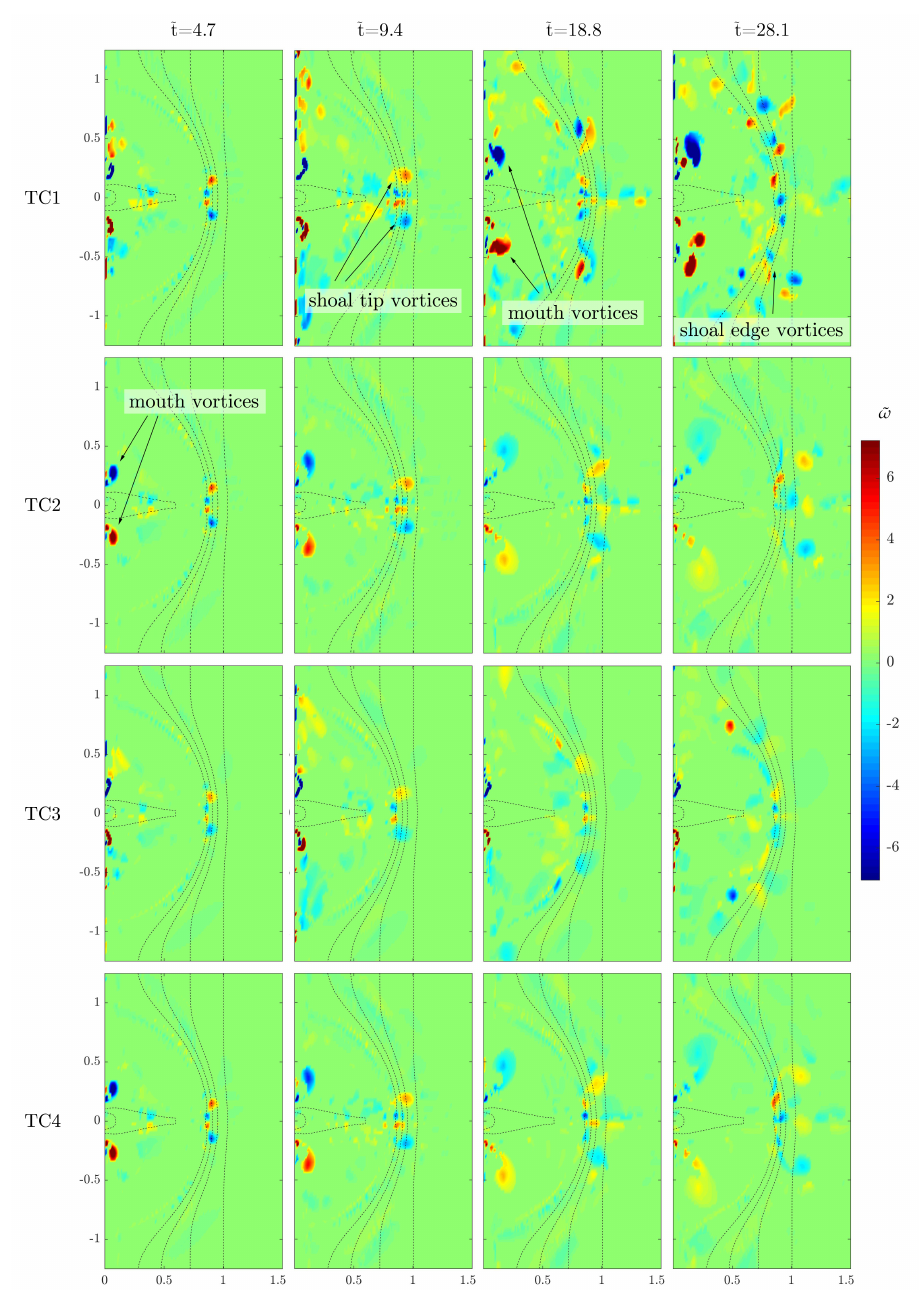
Figure 8. Time evolution of vorticity for the four tests with river current only. Each row represents a single test (from top to bottom: TC1 to TC4). Each column represents a single time level (from left to right: ˜ t = 4.7, 9.4, 18.8, and 28.1). Red tones represent clockwise vorticity; blue tones represent anticlockwise vorticity. The dotted lines show the bathymetry contours of the shoal edge and the main